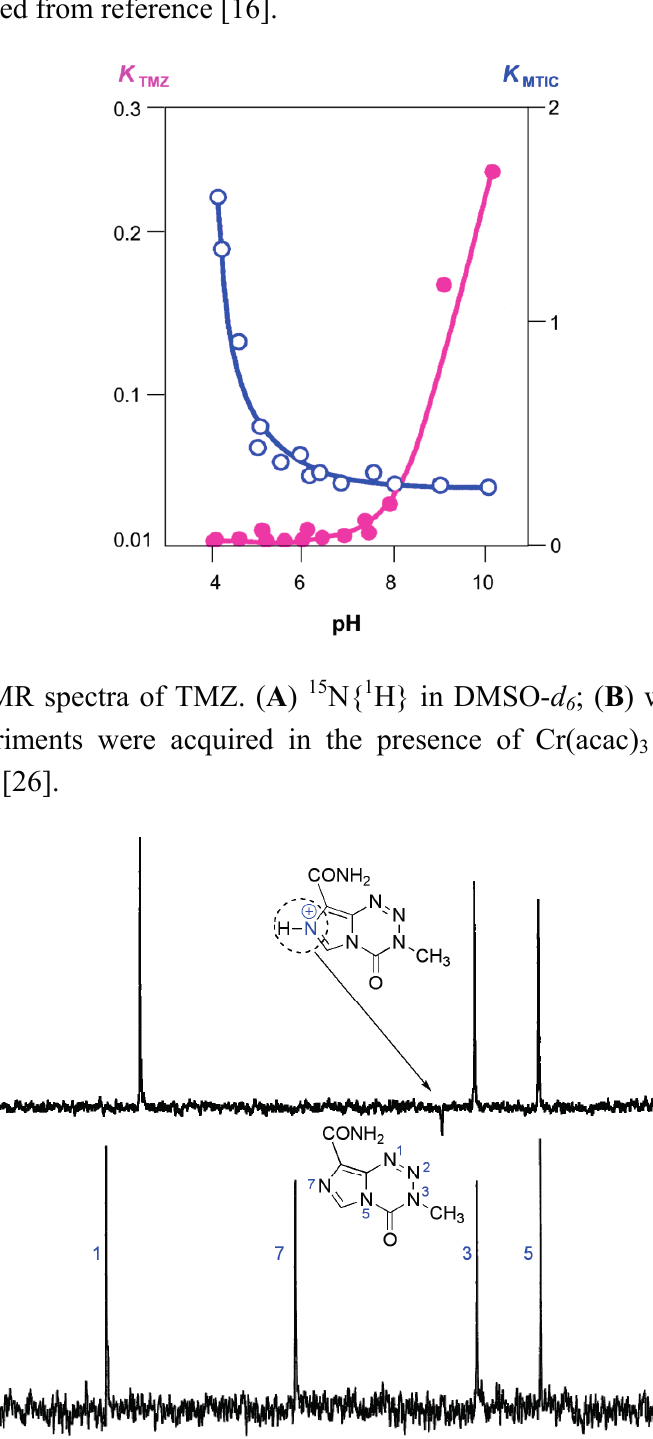
Figure 5. pH Dependence of the pseudo-first order rate constants for hydrolysis of TMZ and MTIC. Adapted from reference [16].